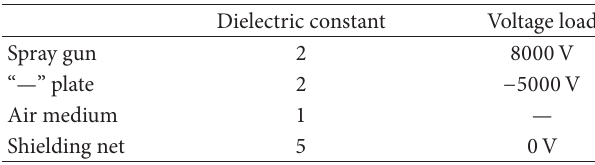
Figure 2: Simplified FEA mesh model. Table 1: Parameters setting.